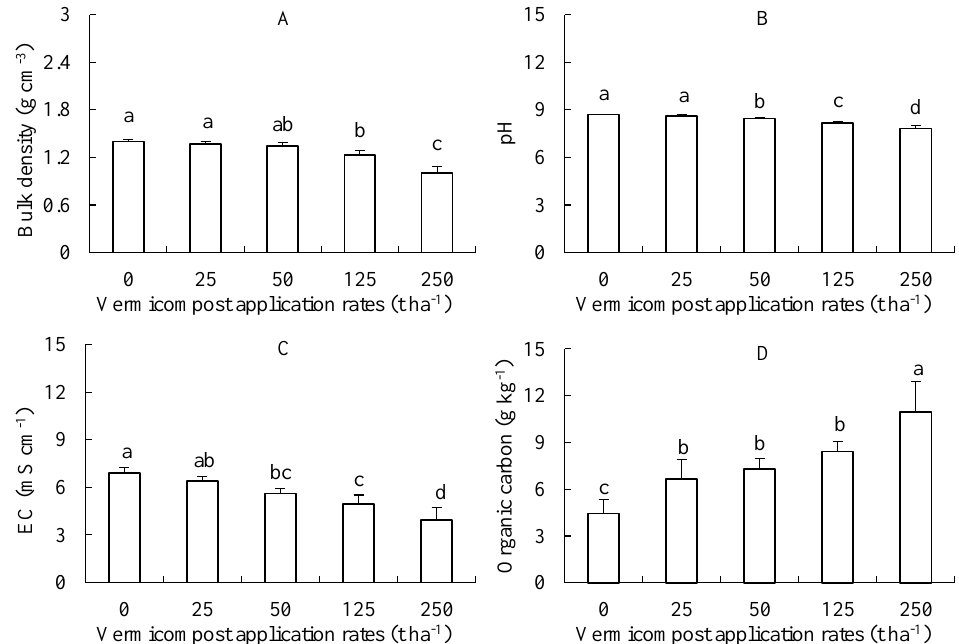
Figure 1. Effects of vermicompost application on bulk density ( A ), pH ( B ), EC ( C ), and organic carbon content ( D ) in mudflat salt-affected soil. Values are the mean of three replicates, and bars show standard deviation. Columns with different letters show a significant difference between sewage sludge amendment rates at p < 0.05 by LSD’s multiple range test. EC, electric conductivity. The content of the soil total N, the alkaline N, the total P, and the available P in mudflat salt-affected soil increased with increasing vermicompost application rates (Table